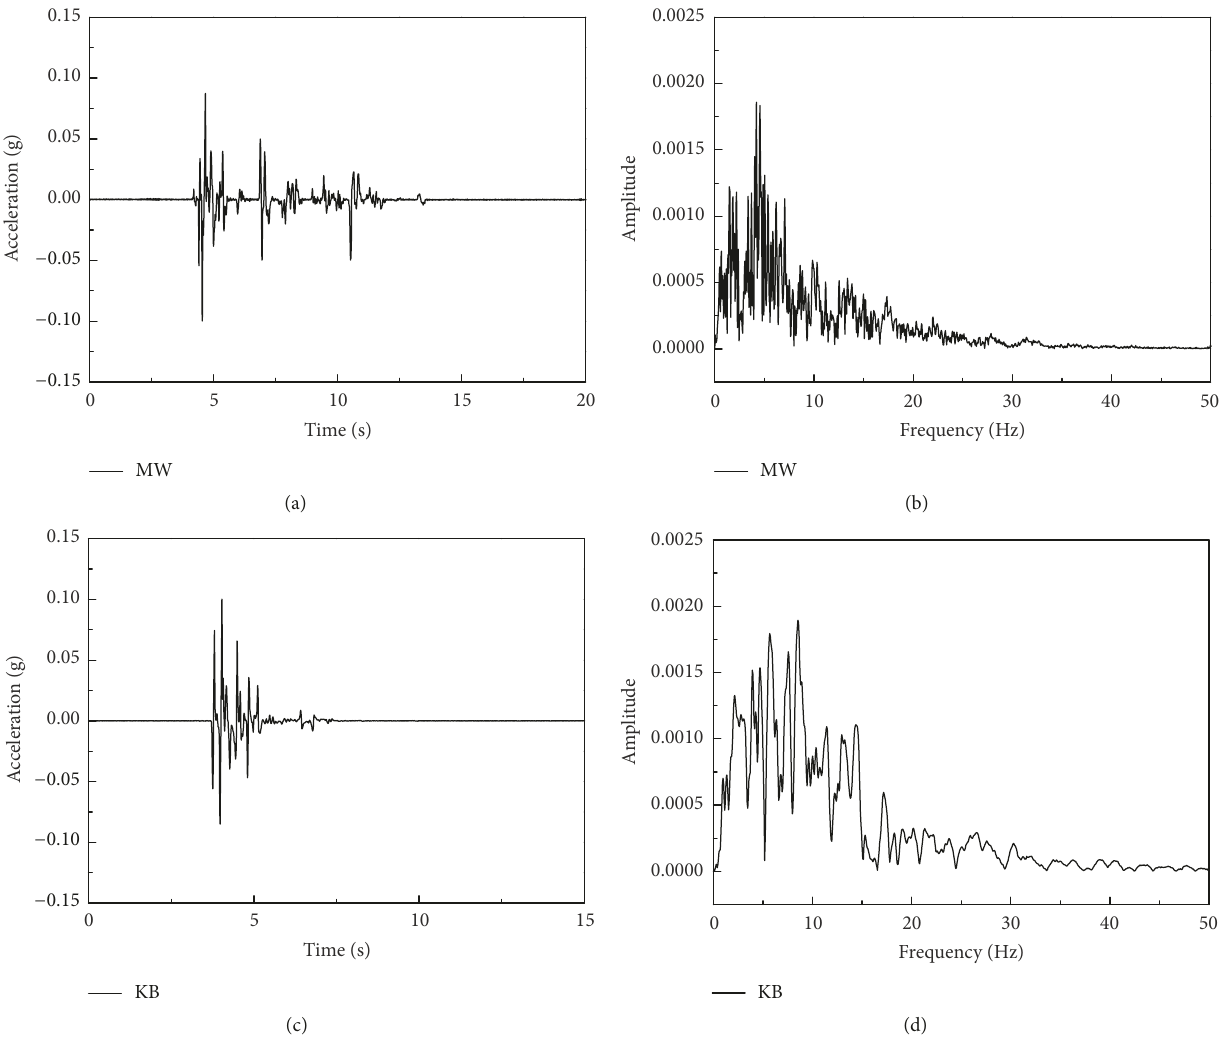
Figure 7: Excitations during testing: (a) MW wave obtained from loading case 1, (b) Fourier spectra of (a), (c) KB wave obtained from loading case 2, and (d) Fourier spectra of (c).